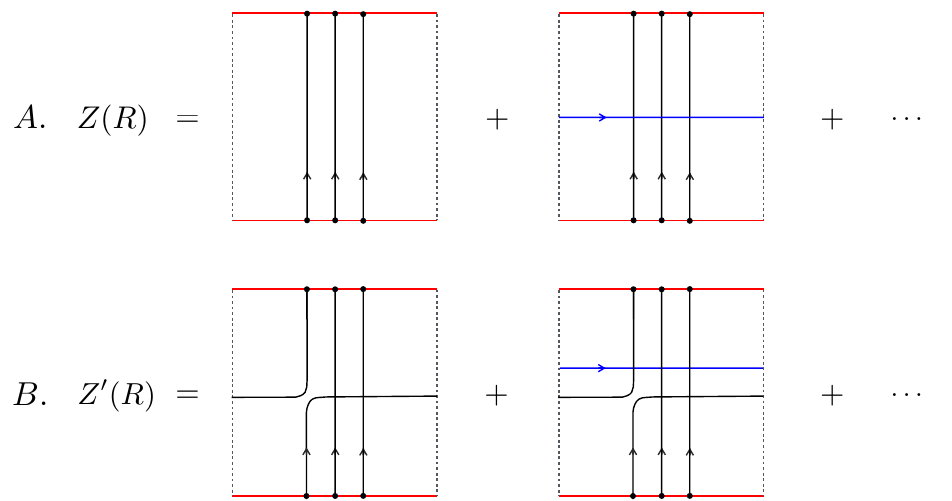
Figure 6 . Low temperature 1 =L 1 (cid:28) 1 expansion of the excited state partition function. The starting point is a square of real size L 1 (cid:29) 1 (solid top and bottom lines) and mirror size R (cid:29) 1 (dashed left and right lines). It supports a Bethe state u represented by a bundle of vertical lines stretching from the bottom to the top. We wrap the square around the cylinder by identifying the two parallel mirror edges. It results in a trace over a complete basis of mirror Bethe states (of the cut o(cid:11) mirror Hilbert space). The leading low temperature contribution comes from the mirror vacuum (empty dashed mirror lines). Next comes the (cid:12)rst wrapping correction, with one mirror magnon going around the thermal circle. We must sum over the magnon’s (cid:13)avors and integrate over its momentum with a proper R dependent measure. The dots stand for the in(cid:12)nite tail of multi- particle mirror states. In A: the real magnon lines all go straight from the bottom to the top. In B: one of the magnon winds once around the world before reaching the top. The two processes